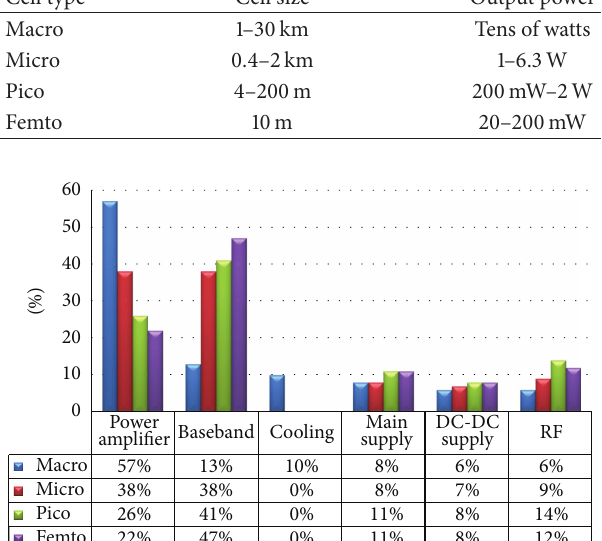
Figure 7: Power consumption of the hardware elements of LTE BSs for different BS types